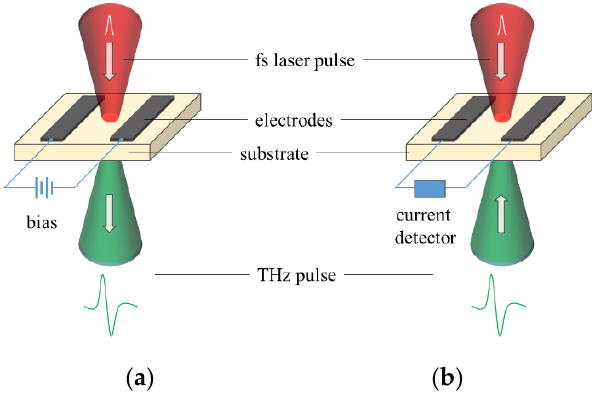
Figure 1. Schematic diagram of photoconductive antenna (PCA) as ( a ) an emitter and ( b ) a detector in a terahertz time domain spectroscopy (THz-TDS) system.